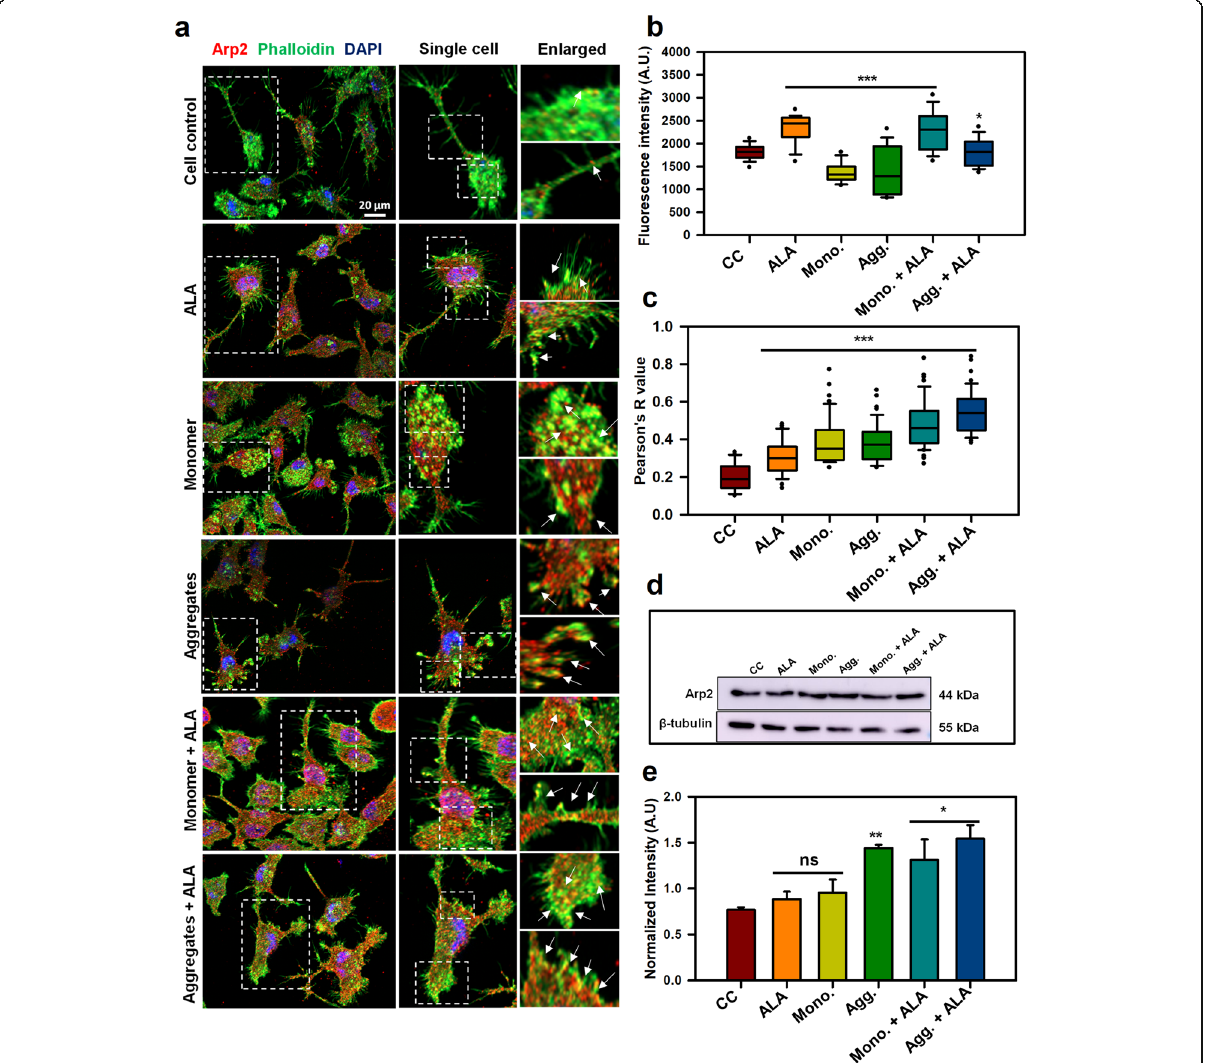
Fig. 6 Enhancement of Arp2/3-mediated actin polymerization in the presence of ALA. Arp2/3 complex plays an important role in nucleating the actin polymerization and provide pushing force for the cell to move forward. After exposure of Tau monomer, aggregates and ALA the abundance of Arp2/3 in microglia was studied by fluorescence microscopy. a Immunofluorescence images indicate the microglia cells stained with Arp2/3 (red), phalloidin (green), DAPI, scale bar is 20 μ m. The enlarged area indicates the colocalization of F-actin and Arp2/3 complex. The enlarged area has been taken from single cell panel and marked with white dotted squares. The white arrow marks indicates concentrated colocalized area inside the cell. b The intracellular intensity of Arp2/3 in the cell was quantified from immunofluorescence images with ZEN 2.3 software and plotted as a fluorescent intensity units ( p < 0.05) for ALA treated groups as compared to cell control. c The Pearson ’ s R value for colocalization was calculated with ImageJ software. The conditions of Tau monomer and aggregtes with ALA are significant, ( p < 0.001). d The quantification of protein levels of Arp2/3 was observed from western blot analysis after 24 h treatment of Tau monomer, aggregates and ALA. e The graph indicates quantification of western blot bands normalized with the loading control β -tubulin. The conditions of Tau monomer and aggregtes with ALA are significant, ( p < 0.05). The significance was analyzed with Tukey ’ s Kramer, significant when mean difference between treatment groups (X-X ’ ) > T (Tukey ’ s criteria). The annotations used in graph are as follows- CC (Cell control), ALA ( α -linolenic acid), Mono. (monomer), Agg. (aggregates), Mono. + ALA (monomer plus ALA), Agg. + ALA (aggregates plus